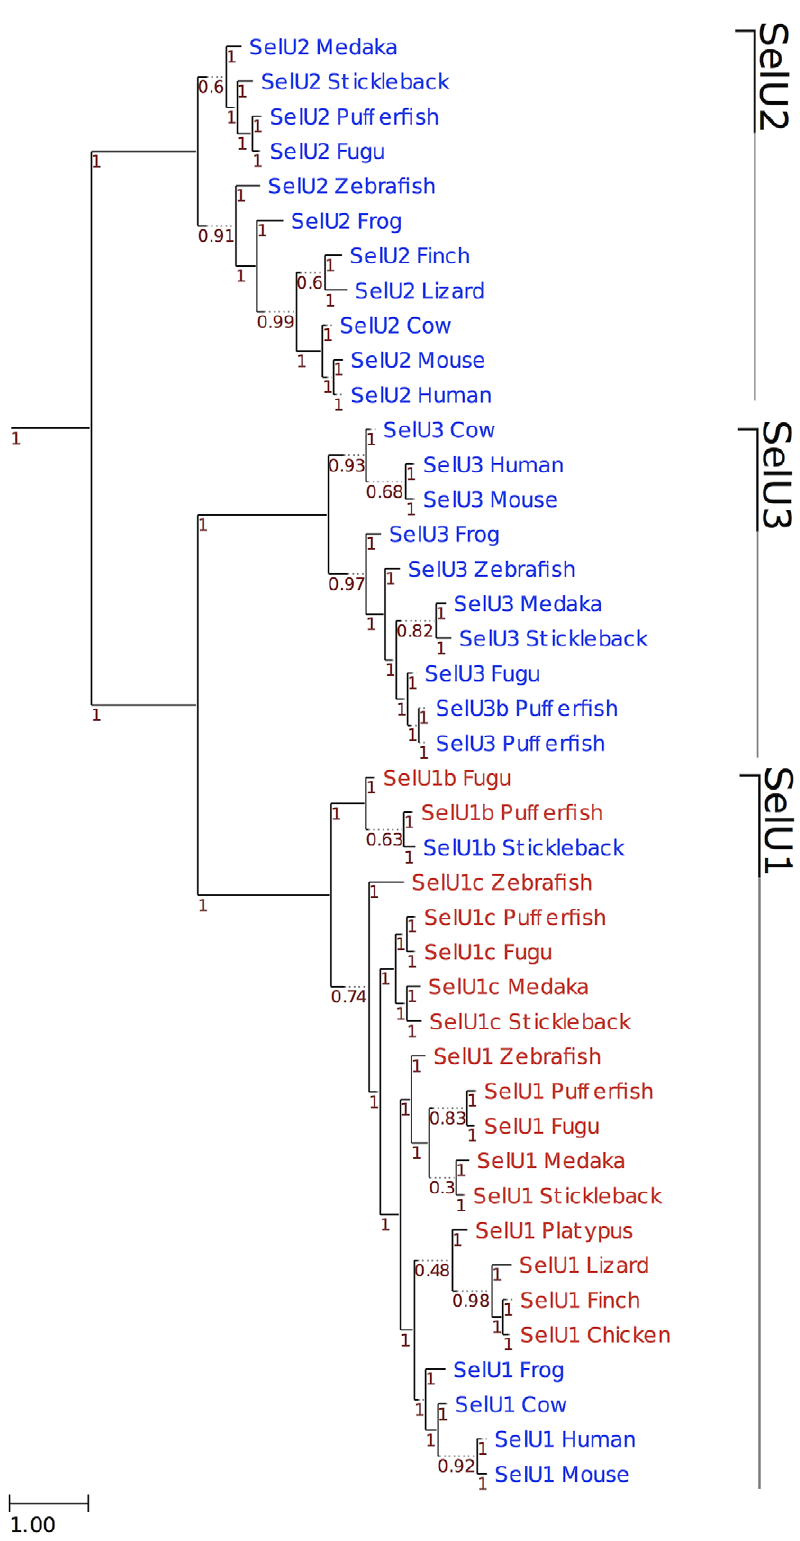
Figure 9. Phylogeny of SelU family in vertebrates. ML tree computed using the JTT substitution model. Sec-containing proteins are shown in red, whereas the Cys-containing homologs are shown in blue. At the bottom left, the distance scale in substitutions per position is shown. Branch support is shown along the tree in red.